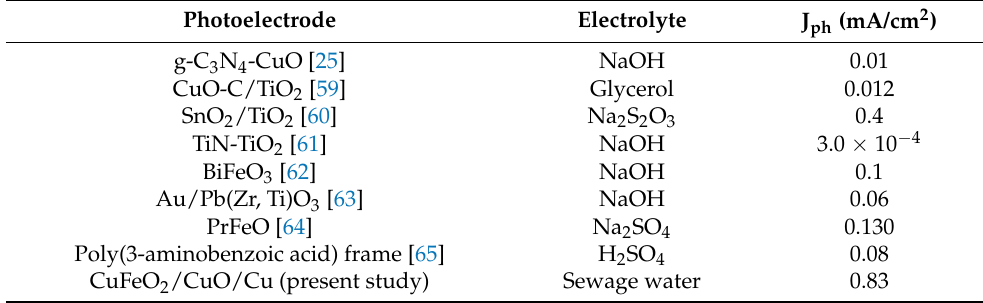
Table 2. Comparison of the current study (using sewage water as an electrolyte) with the previous studies in the literature